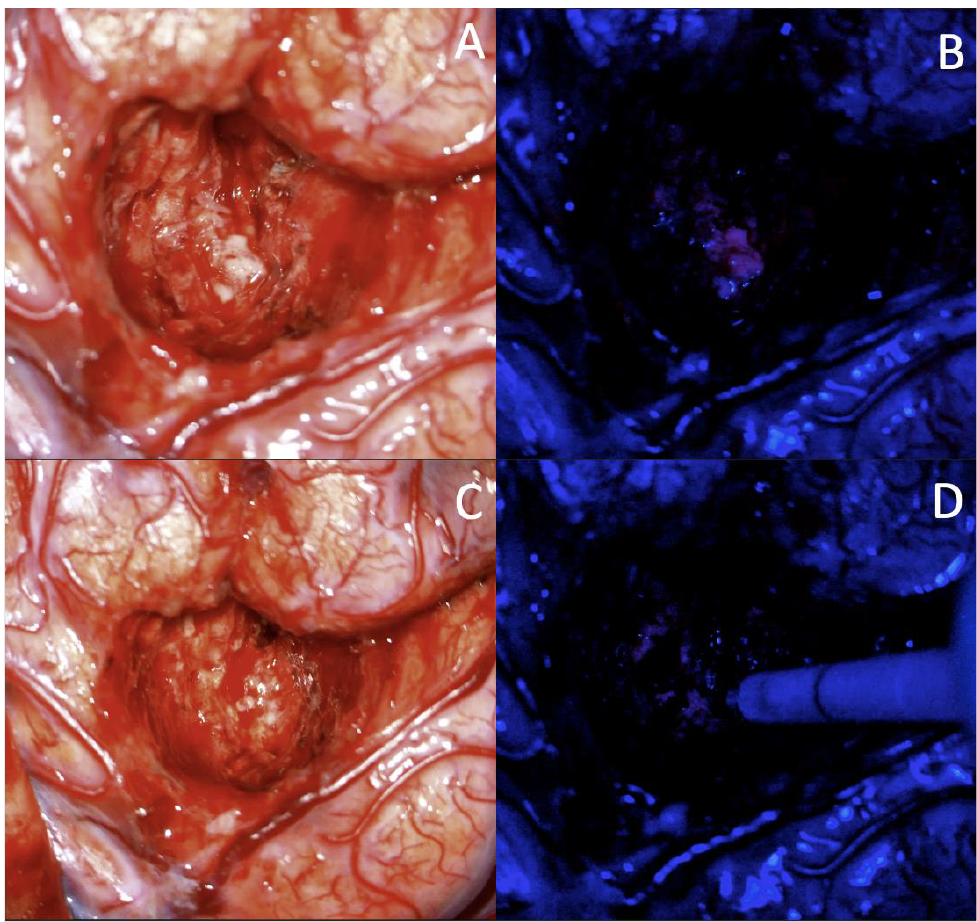
Figure 2. ( A ) Intraoperative visualization of High-grade glioma through a sulcus. ( B ) with fluorescent residual tumor located using 5-ALA. ( C ) Without 5-ALA fluoroscopy, achieving total resection would be impaired due to difficulty differentiating malignant from non-neoplastic tissue. After identifying the residual lesion and removing the remaining tissue, the residual cavity through the sulcus is seen and ( D ) the reduced fluorescence indicates removal of all visible malignant tissue.